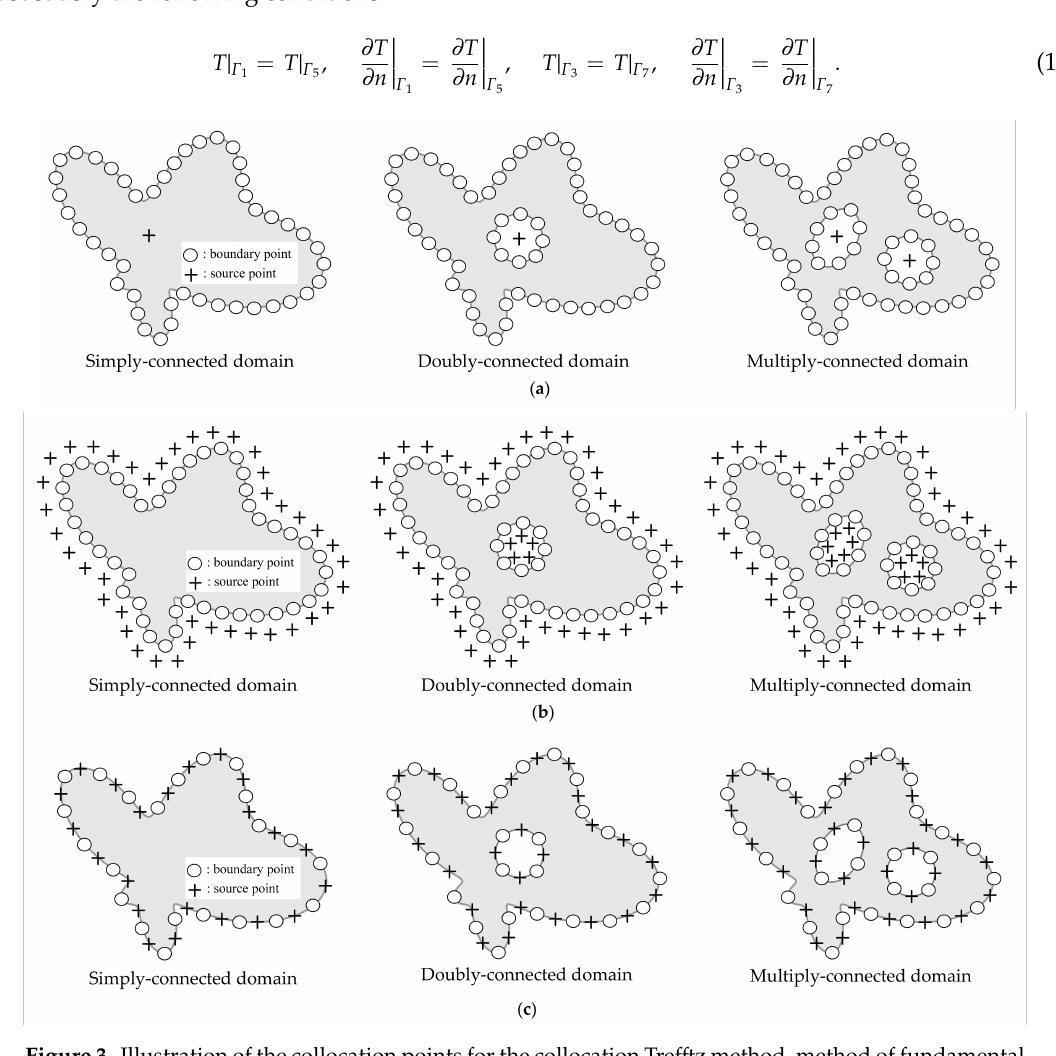
Figure 3. Illustration of the collocation points for the collocation Tre ff tz method, method of fundamental solutions, and multiple source meshless method. ( a ) Collocation scheme for the CTM, ( b ) Collocation scheme for the MFS, ( c ) Collocation scheme for the